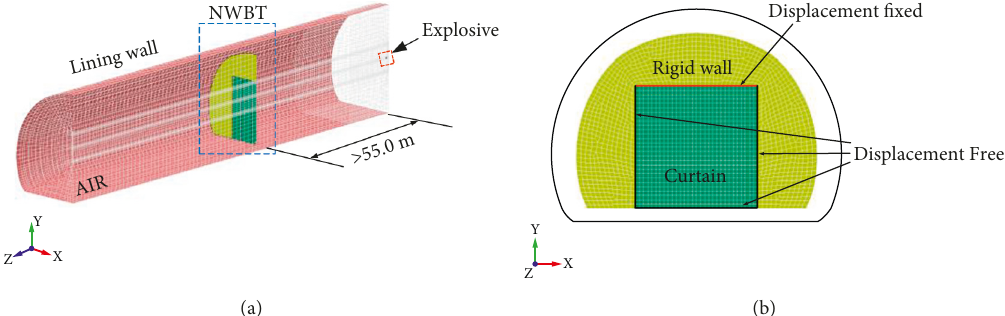
Figure 7: Numerical model: (a) profile graph and (b) symmetric grid of NWBT about